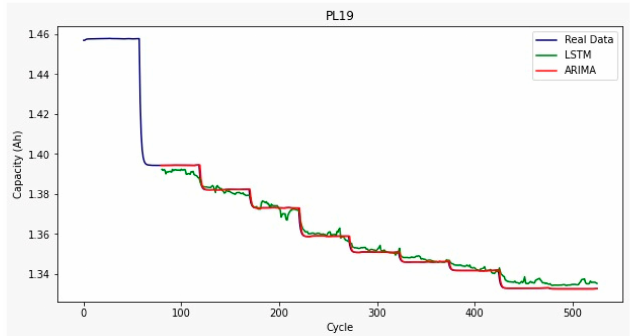
Figure 14. Train, test, and predicted data results from ARIMA and LSTM models for PL19.